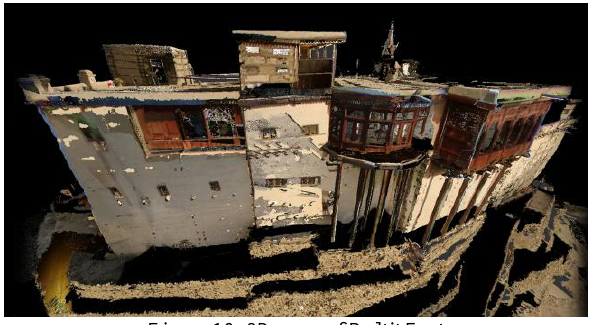
Figure 10. 3D scan of Baltit